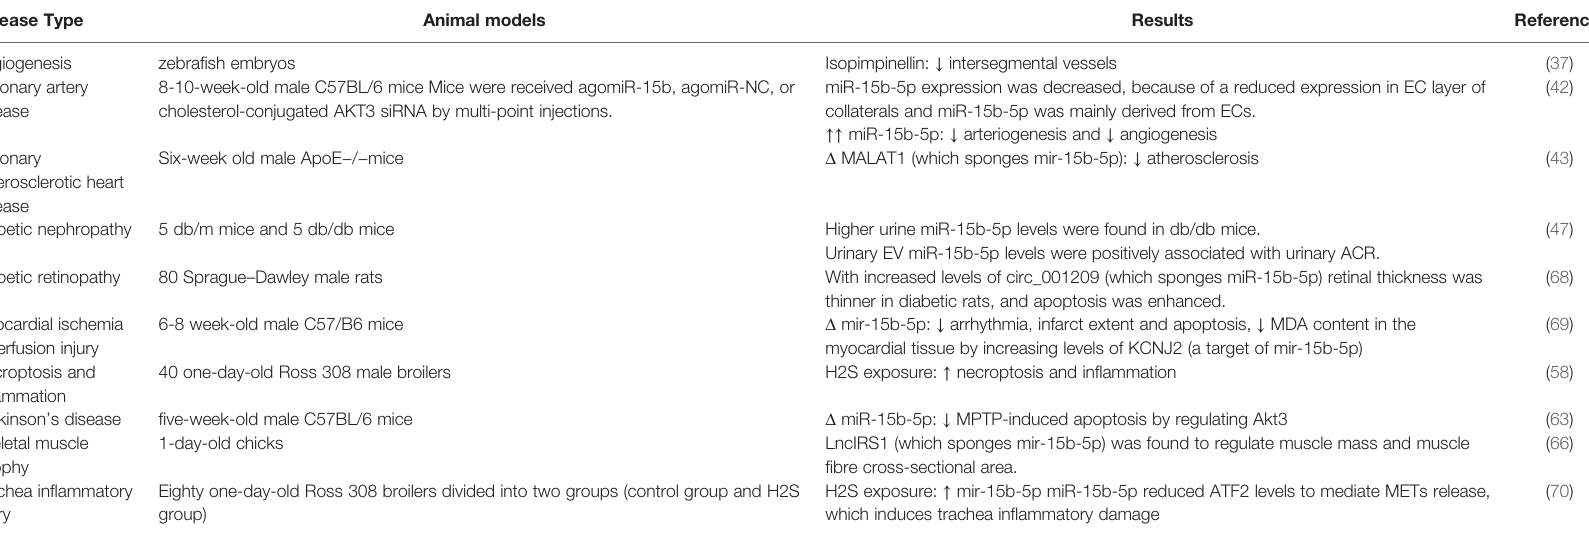
TABLE 5 | Summary of studies on the role of miR-15b-5p in non-malignant conditions ( D , knock-down or deletion; MDA, malondialdehyde; ECs, endothelial cells; ACR, Albumin-to-Creatinine Ratio; H2S, Hydrogen sul fi